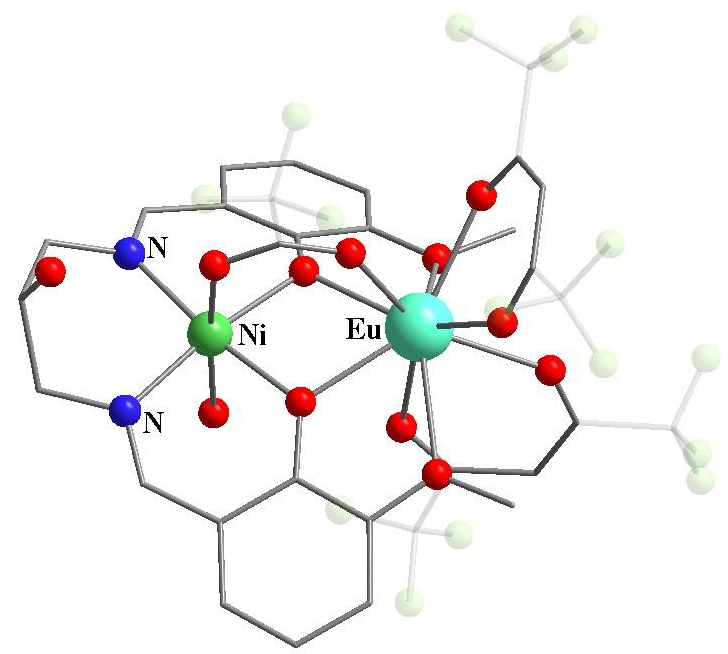
Figure 39. Molecular structure of 87 [127]. CF 3 groups are transparent for clarity. The cif has been retrieved from CCDC. CCDC number is 1556429. The nitrogen base, as an initial part of the complex, can further participate in the co- crystallization with fluorinated β -diketonate [129]. In particular, the tetranuclear bimetal- lic complex 91 was obtained by the reaction of Cd(pymt) 2 (phen) 2 ( 90 ) with Cu(hfac) 2 in acetonitrile (Scheme 32) [129]. The heterometallic structure 91 was formed based on the ttpt derived from hfac. Cadmium(II) both coordinated the diketonate anion and built a heterometallic framework of 91 due to the bridging oxygen atoms of ttpt (Figure 40). In addition, three hydroxyl oxygen atoms of two tpt and phen molecules formed the [CuO 3 N 2 ] coordination environment of copper(II) ions.